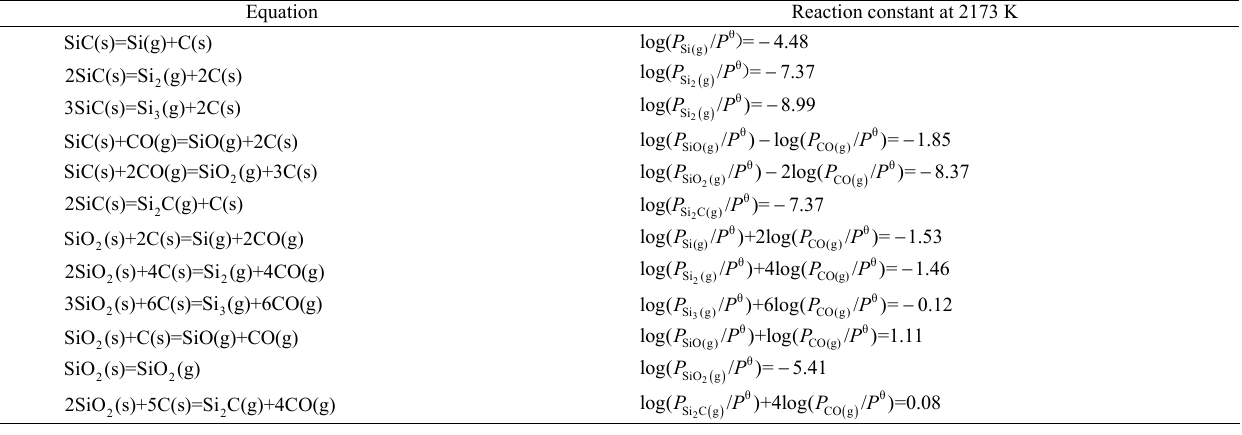
Table 1 Reactions and related thermodynamic data in the Si–O–C system at 2173 K Equation Reaction constant at 2173 K